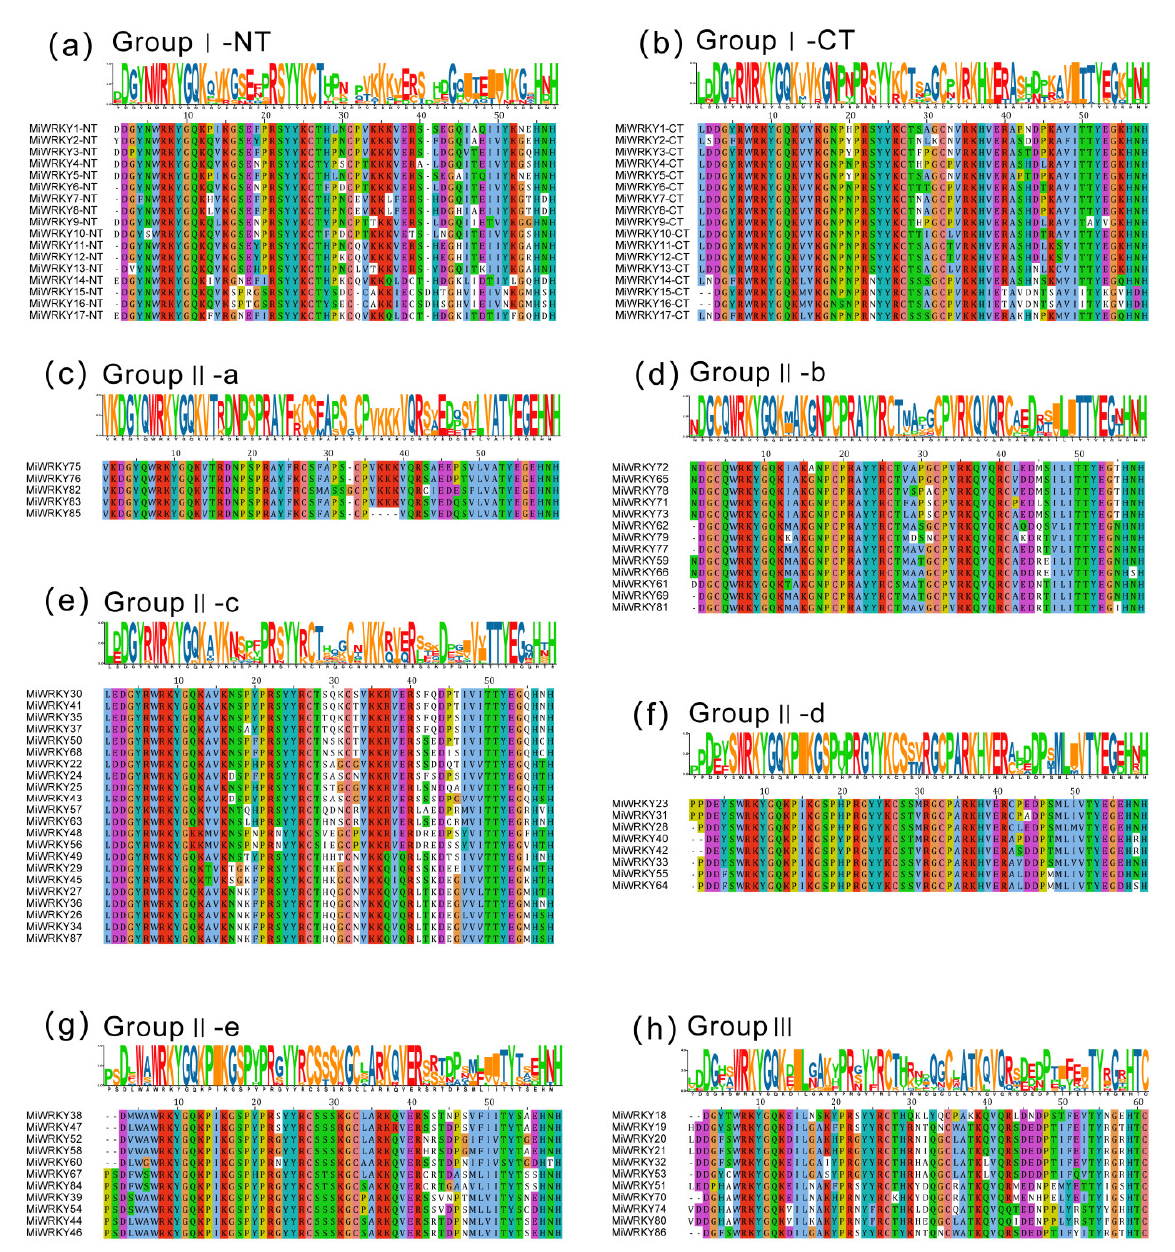
Figure 1. Phylogenetic tree of identified MiWRKY proteins. Select AtWRKY proteins served as rep- resentatives for the different groups. Group I to Group III WRKY proteins are shown in different colors. The mango and Arabidopsis WRKY domains are represented by black solid circles and red circles, respectively. WRKYs named with the suffix -NT or -CT represent either the N-terminal WRKY domain or the C-terminal WRKY domain of MiWRKY proteins with two WRKY domains.